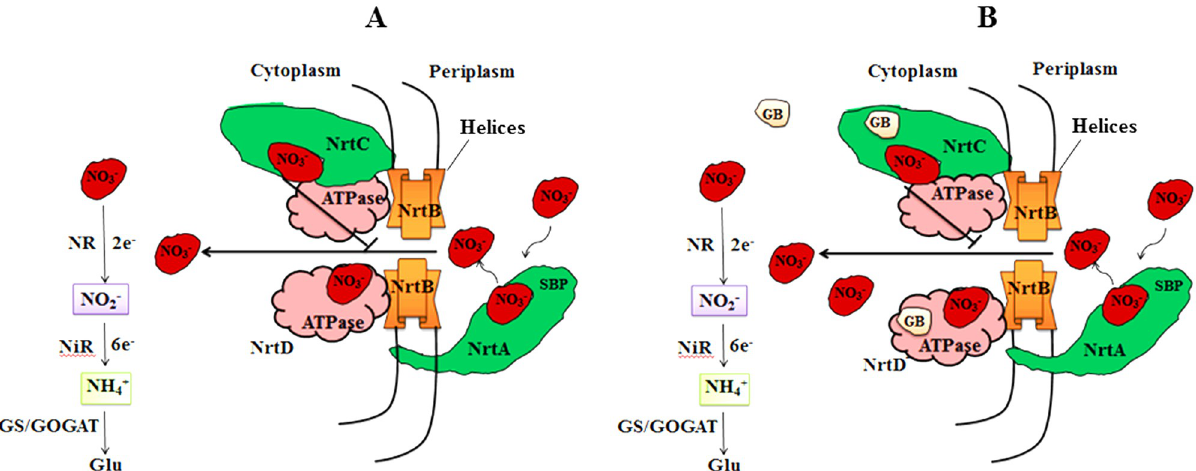
Fig 1. A schematic representation of nitrate transport. (A) The TMD proteins of the ABC-nitrate transporter, periplasmic subunit nrtA scavenges nitrate of the solution and transports across the lipid bilayer of the membrane through nrtB pore. When nitrate level rises in the cell, ABC protein, NrtC binds to nitrate and acts as negative regulator by inhibiting nitrate uptake, while nrtD binds and hydrolyzes ATP to induce conformational changes in TMDs (nrtAB). Extra cytoplasmic helices running parallel to the cytoplasmic membrane provide contact to TMDs proteins. (B) Interaction of GB with nrtACD